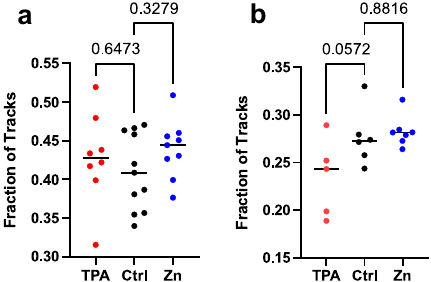
Figure 6. The effect of Zn 2+ on fraction bound. ( a ) Fraction bound analysis for HaloTag-GR cells. Fraction bound was calculated as the number of tracks that were present for at least 5 frames (500 ms) divided by the total number of detected tracks. ( b ) Same as in ( a ), except with HaloTag-CTCF cells and with tracks that were present for at least 5 frames (2.5 s). Numbers indicate the p-value calculated using a one-way